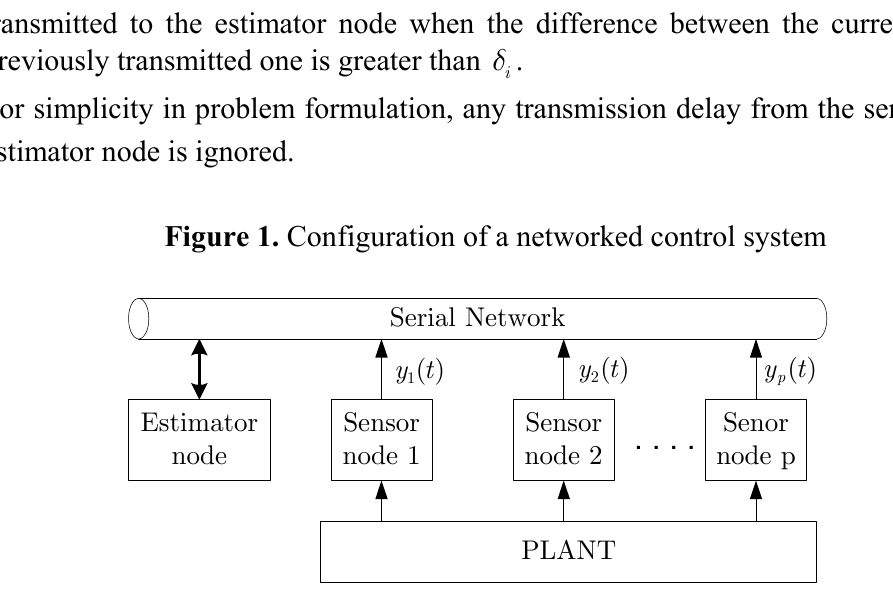
Serial Network y ( ) y t ( ) ( ) y t 2 p 1 Sensor Sensor Senor . . . . node 1 node 2 node p PLANT